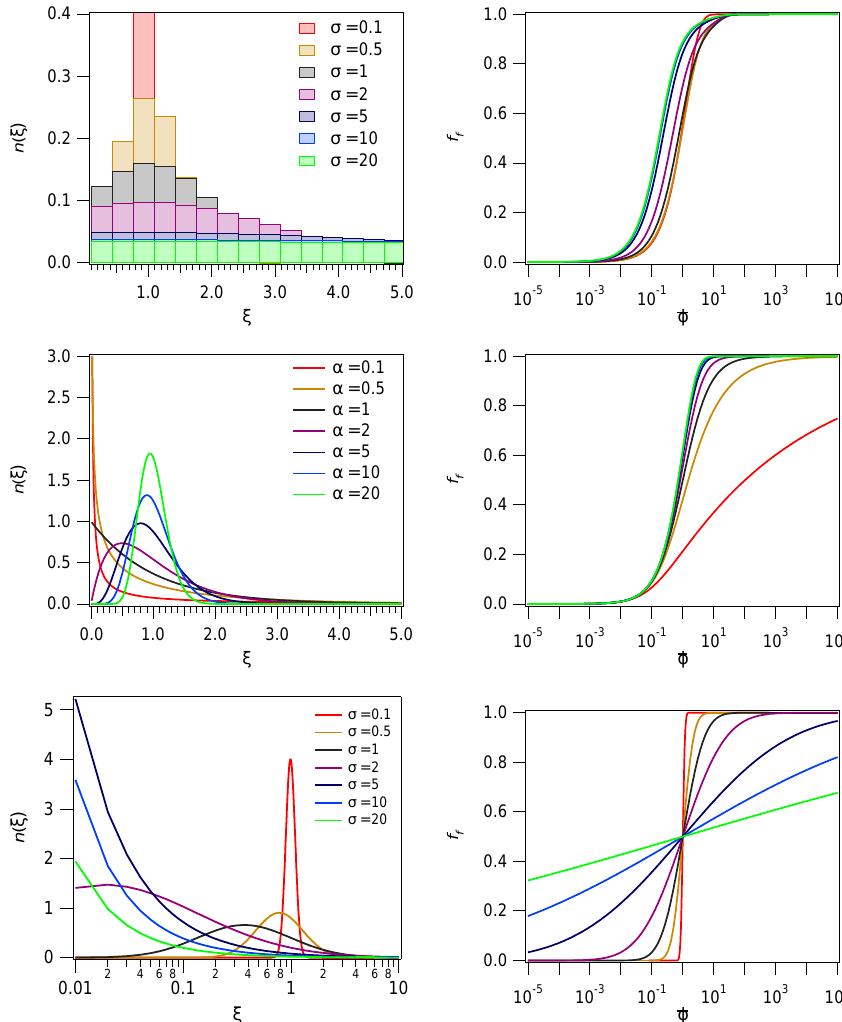
Fig. 1. Ice nucleation probability dispersion functions (left panels) and corresponding ice nucleation fraction (right panels). Shown are sectional (based on a normal distribution using 20 bins, top panels), gamma (middle panels) and lognormal (bottom panels) distributions.